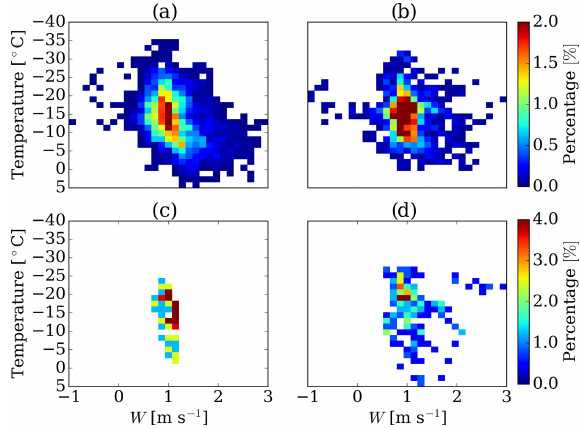
Figure D2. Same as Fig. D1, but for W .